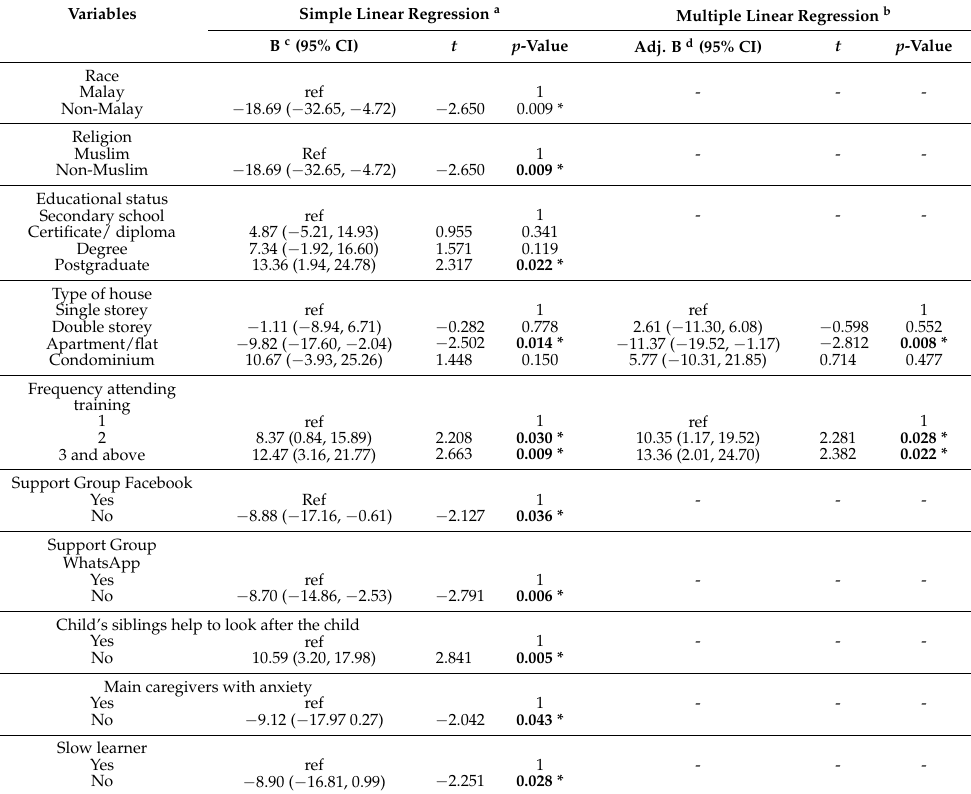
Table 4. Factors associated with perceived quality of life (QoLA Part A) among main caregivers ( N = 116). Variables Simple Linear Regression a Multiple Linear Regression